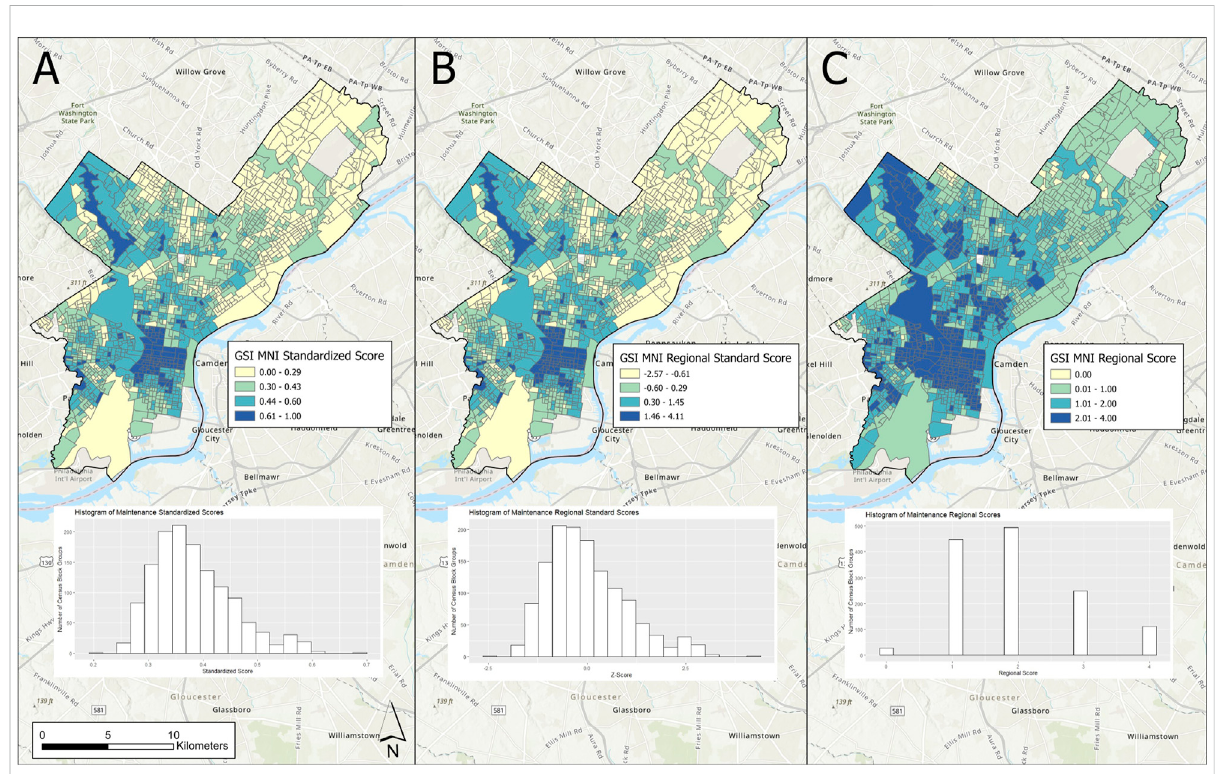
FIGURE 5 TheanalysisoftheGSIMaintenance NeedsIndexresults. (A) Thespatial distribution oftheGSIMNII basedon thestandardizedscoringmethod. (B) The spatial distribution of the GSI MNI based on the z-scores. (C) The spatial distribution of the GSI MNI based on the regional scoring method. Base Map Source: Esri, DeLorme, HERE, TomTom, Intermap, increment P Corp., GEBCO, USGS, FAO, NPS, NRCAN, GeoBase, IGN, Kadaster